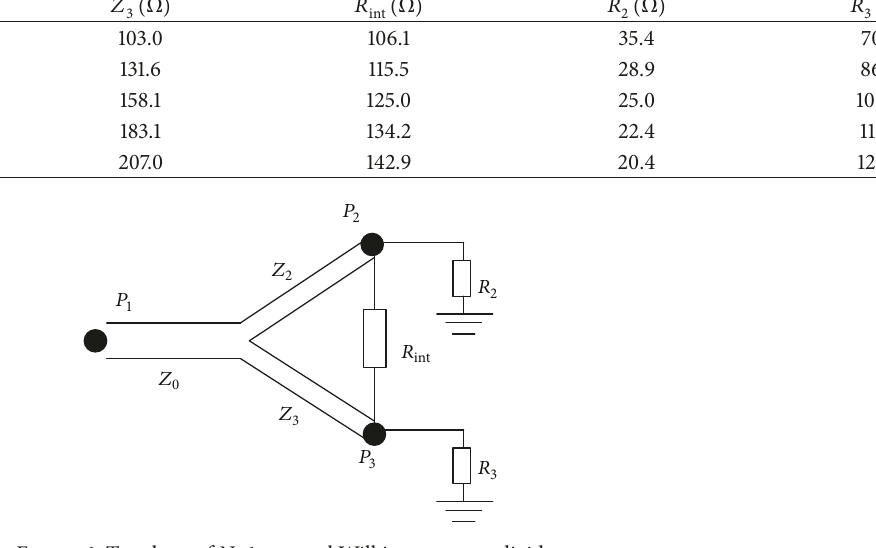
Figure 1: Topology of N :1 unequal Wilkinson power divider.